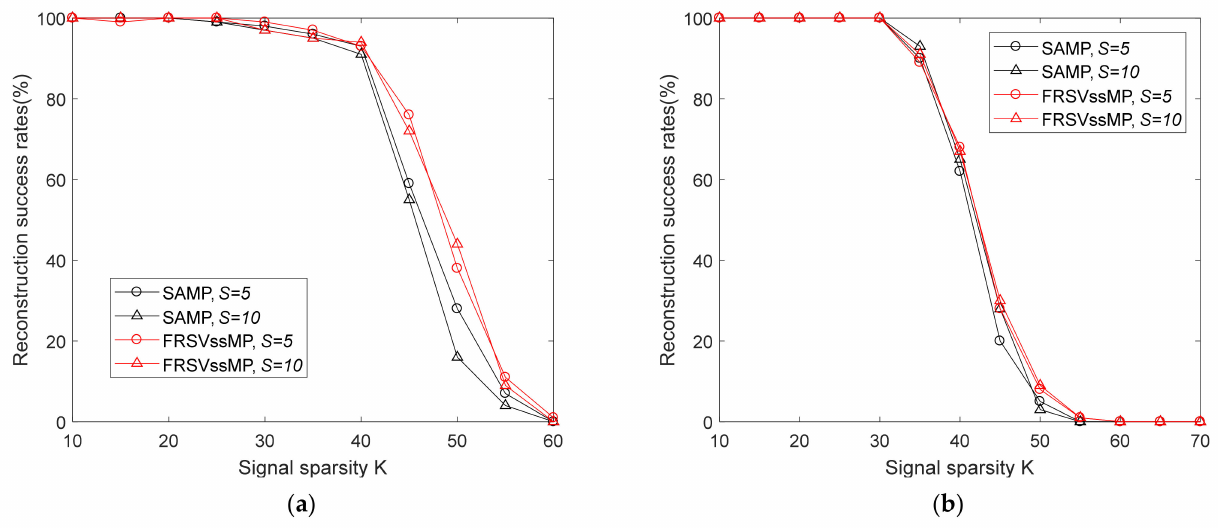
Figure 7. Reconstruction success rates vs. variable step sizes. ( a ) Synthetic signals; ( b ) Real